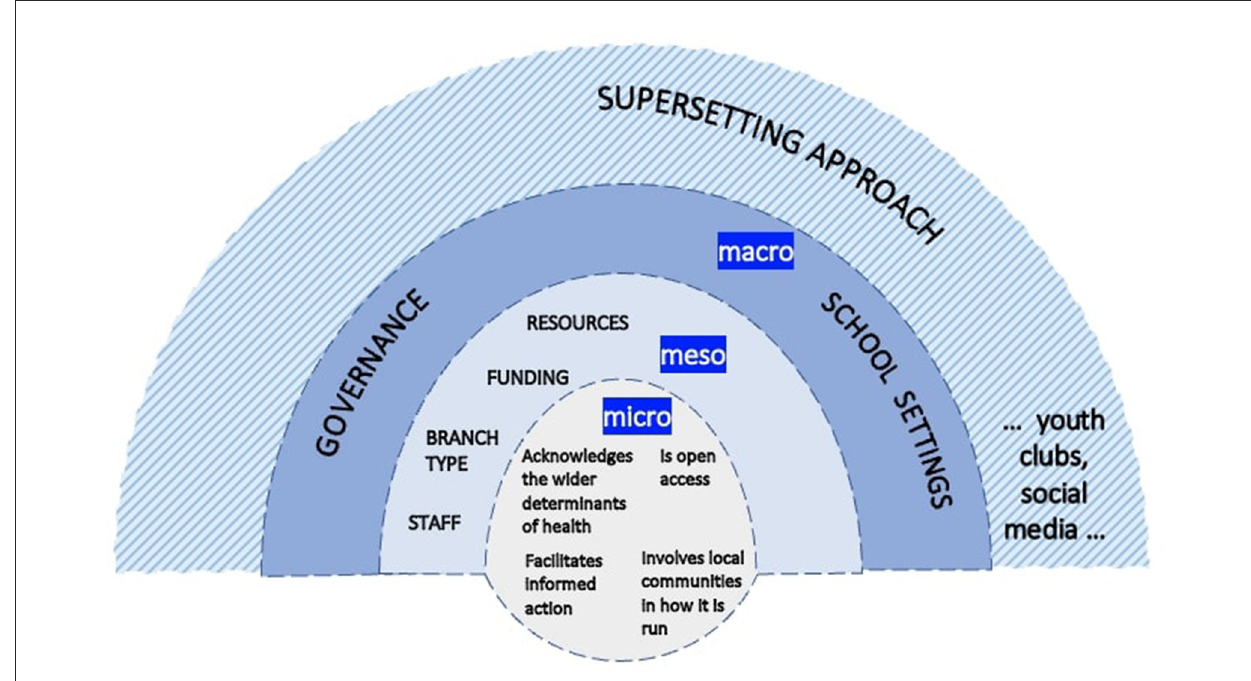
FIGURE1 Conceptual model of the public library as part of a supersetting approach for health literacy development.